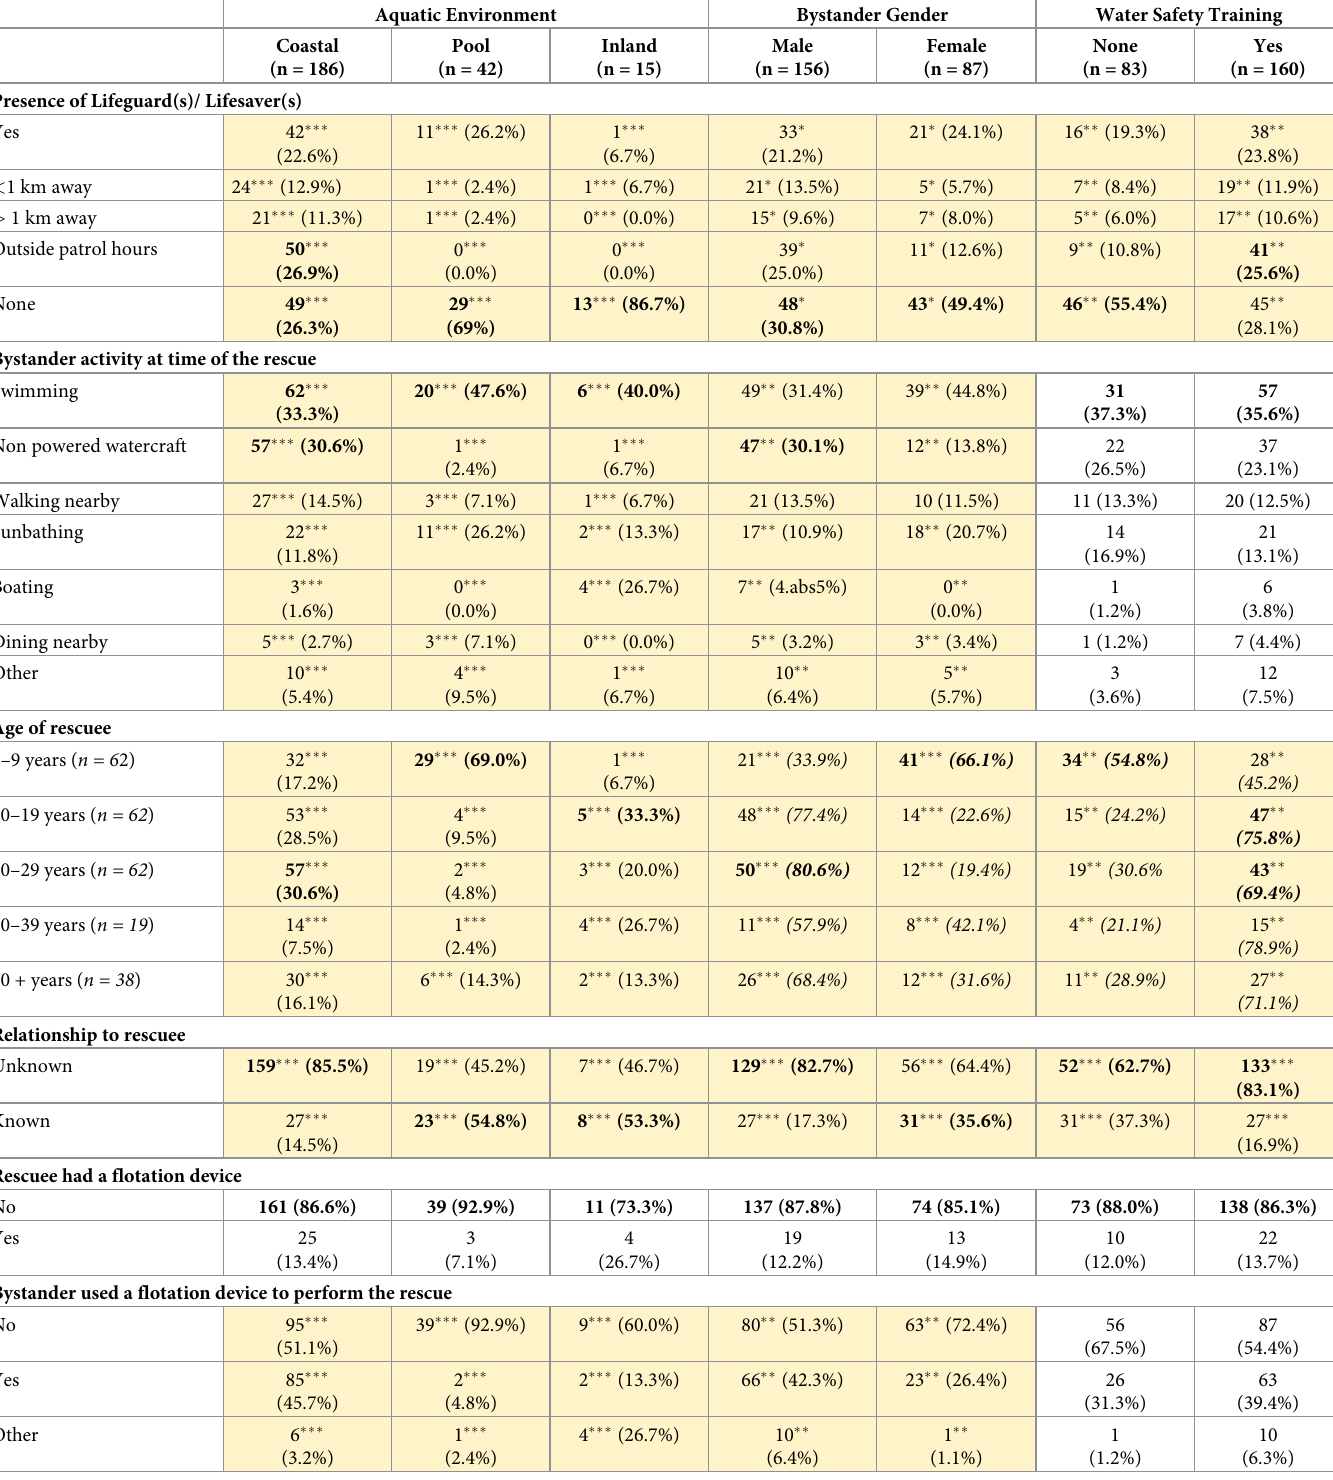
Table 4. Details surrounding the context of the bystanders’ most recent rescue. Values in bold represent maximums for relevant categories. Shaded areas were found to be statistically significant. Asterisks represent the significance level of the relationship, where � = p � 0.05; �� = p � 0.01 and ��� = p �